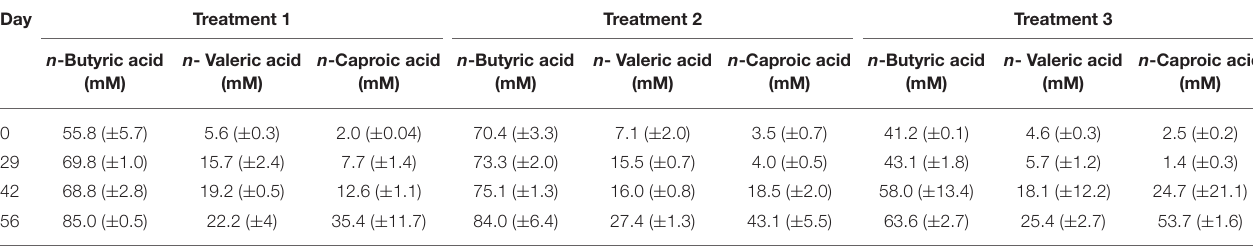
TABLE 3 | Carboxylic acid concentrations at transitional time points during the field-scale trial for Experiment 3. Day Treatment 1 Treatment 2 Treatment 3 n -Butyric acid (mM)